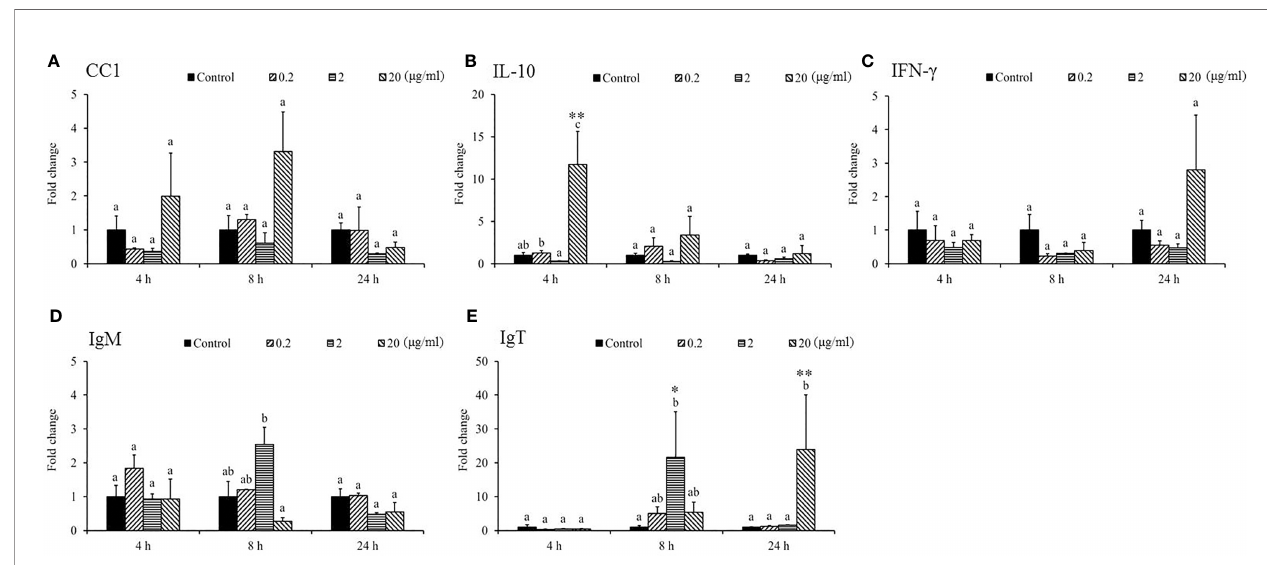
FIGURE 5 | Gene expression of immune genes in the spleen tissue from Sarcodia suiae water extract (SSWE) treated cobia. Spleen samples were collected from fi sh injected with PBS (Control) or SSWE and the expression of (A) CC1 , (B) IL-10 , (C) IFN- g , (D) IgM , and (E) IgT was analyzed. The values are shown as mean + SEM (N = 3). Signi fi cant differences between samples and their time matched control group are shown with asterisks (* p <0.05 and ** p <0.01 and differences between groups are indicated by different